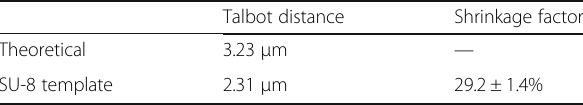
Table 1 Calculated and measured Talbot distance and the shrinkage